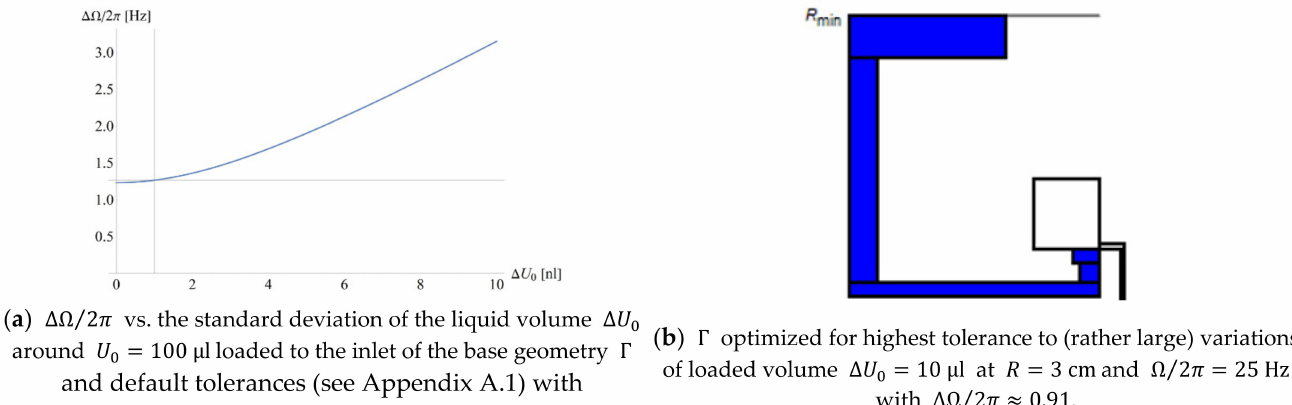
Figure 7. ( a ) Spread ∆Ω as a function of the precision of the loaded volume ∆ U 0 with default other values { ∆ γ k } , with the dotted lines representing the values used and obtained for the default parameters (see Appendix A.1). ( b ) Structure Γ (excerpt) optimized for minimum standard deviation ∆Ω caused by a comparatively poor volume precision ∆ U 0